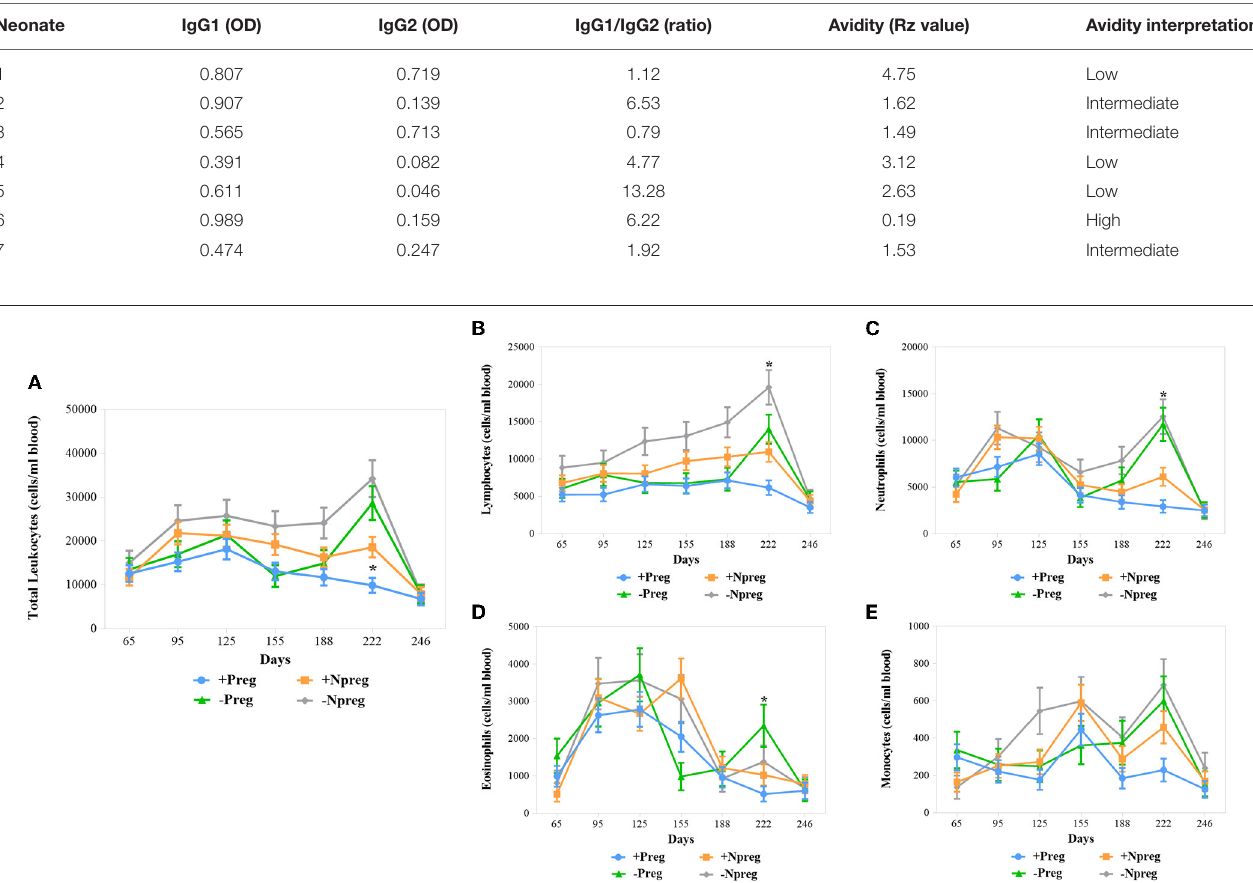
FIGURE 4 | Mean leukocytes counting in blood from cows of four experimental groups. Total leukocytes (A) and absolute lymphocytes (B) ; neutrophils (C) ; eosinophils (D) and monocytes (E) . Each point represents the mean ± standard error of mean (SEM) at the different sampling times for groups. The significant statistical differences between groups were analyzed: * p <